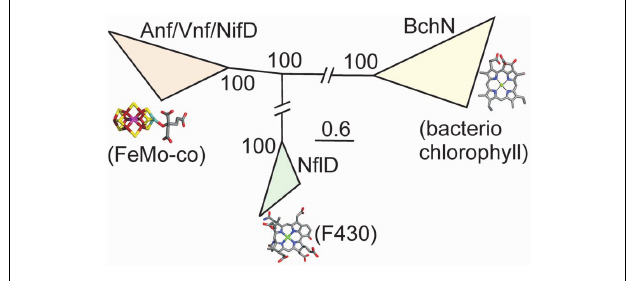
FIGURE 2 | Bayesian inferred phylogenetic reconstruction of Anf/Vnf/NifD, BchN, and NflD proteins. The putative substrates and cofactors for each protein lineage are indicated below each respective clade. Posterior probabilities for each collapsed node are indicated. Nodes have been collapsed and hashes introduced to conserve space.